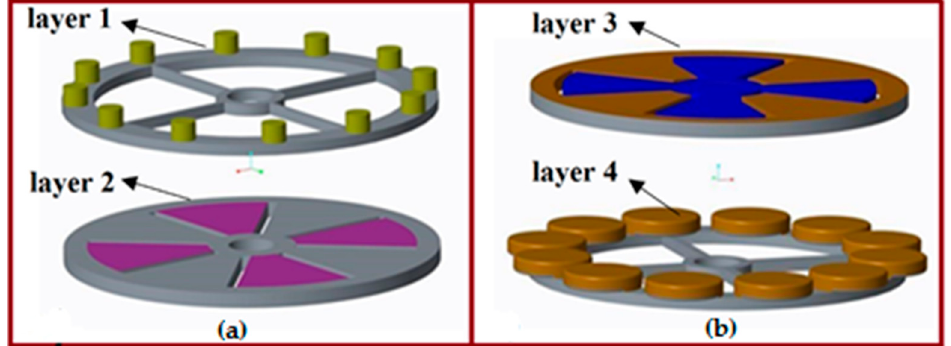
Figure 3. Schematic diagram of the hybrid NG: ( a ) schematic diagram of the rotor part of the hybrid NG; and ( b ) schematic diagram of the stator part of the hybrid NG.